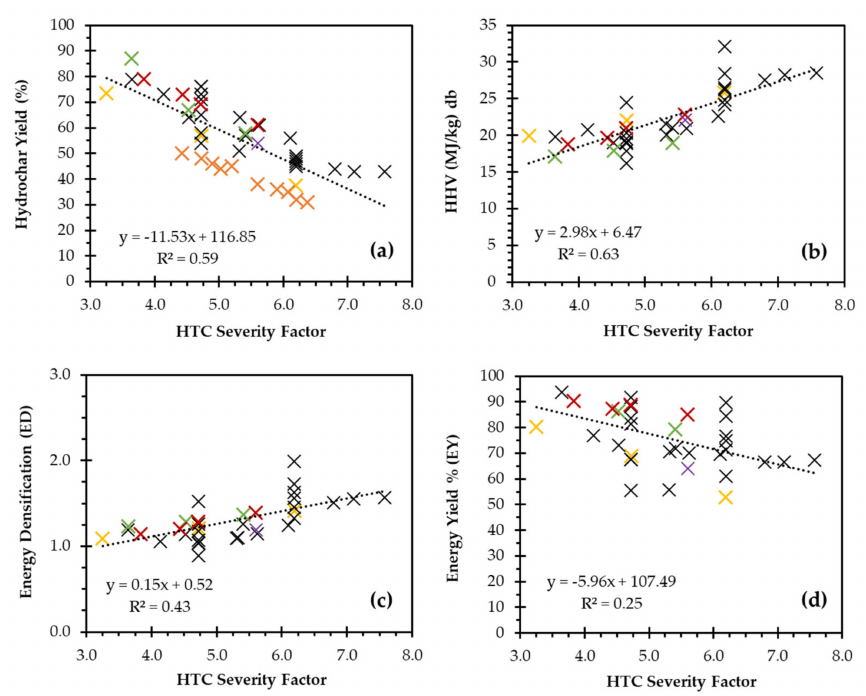
Figure 2. Correlations of HTC severity factor and hydrochar: ( a ) yield, ( b ) HHV, ( c ) energy densifica- tion, and ( d ) energy yield of grass-derived hydrochars. The different colours represent different grass types; black = miscanthus [2,8,10–12], green = switchgrass [12], red = energy grass [21], orange = lawn grass [22], purple = campus grass [15] and yellow = campus grass (this study).